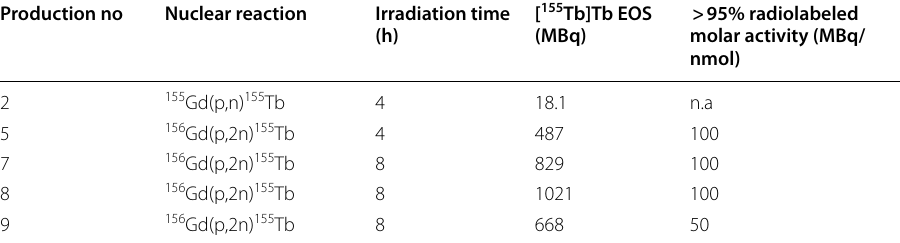
Productions 3 and 6 were excluded due to technical failures of the separation panel. To calculate the separation yield, the EOS activity was corrected to EOB time considering the decay correction (sixth column) and then used to calculate the fraction of initial activity recovered after the separation Table 3 Quality control of terbium-155 after the radiochemical separation process (the molar activity of radiolabeled